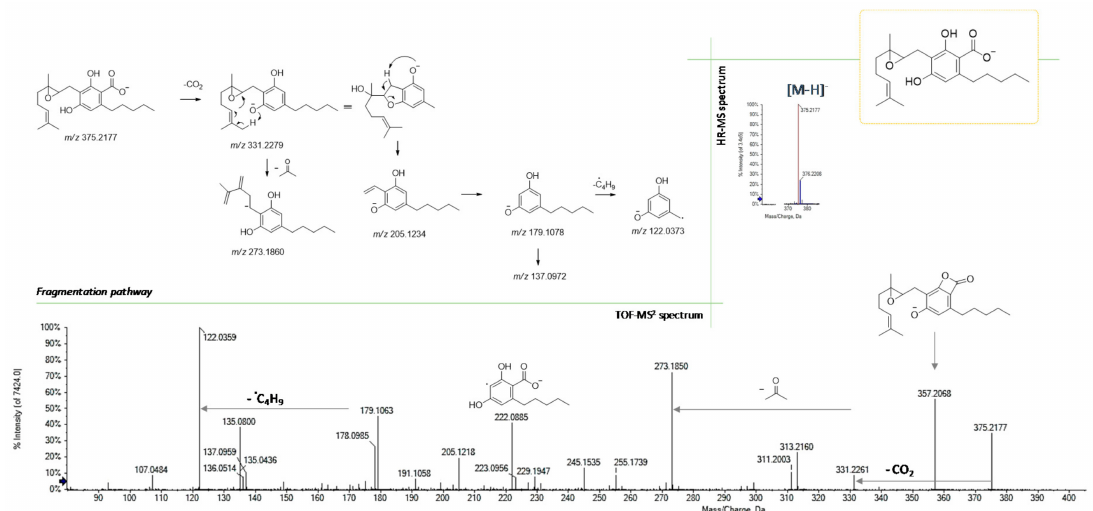
Figure 7. HR-MS and MS / MS spectra of 6,7-epoxyCBGA (at m / z 375.2177) and the proposed fragmentation